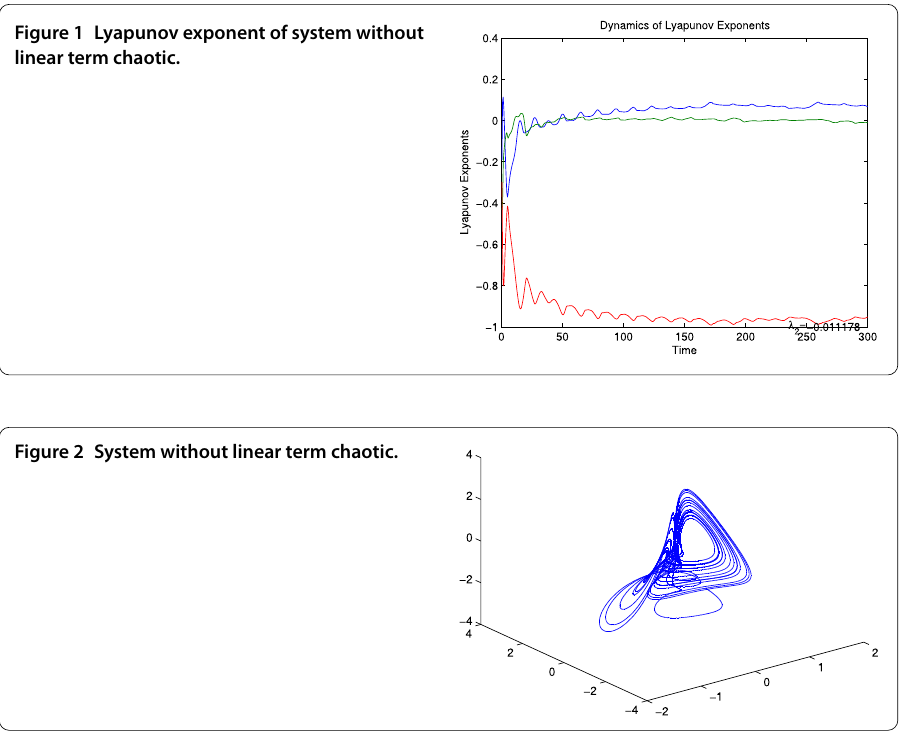
Figure 1 Lyapunov exponent of system without linear term chaotic.